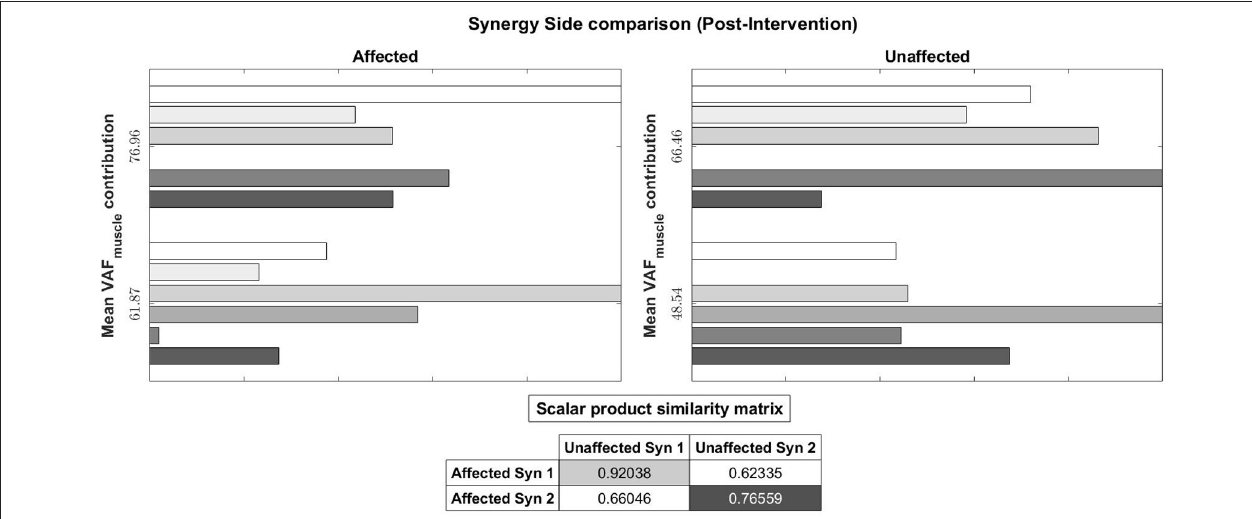
FIGURE 11 | Muscle synergy vectors of Subject 2, Post intervention, Full Gait cycle. With the same muscle synergy matching method, The order of muscle synergies for Subject 2 on the affected side was matched with the order of muscle synergies on the unaffected side (1st synergy on the affected side is matched with the 1st synergy on the unaffected and so